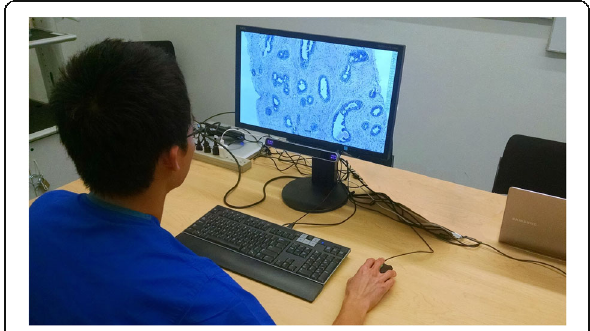
Fig. 1 A remote eye-tracking system (SensoMotoric Instruments ’ Remote Eye-tracking Device – mobile; SMI REDm) mounted to the bottom of a computer monitor. In this study, a participating pathologist is inspecting a digital breast biopsy (Brunyé, Mercan, et al.,